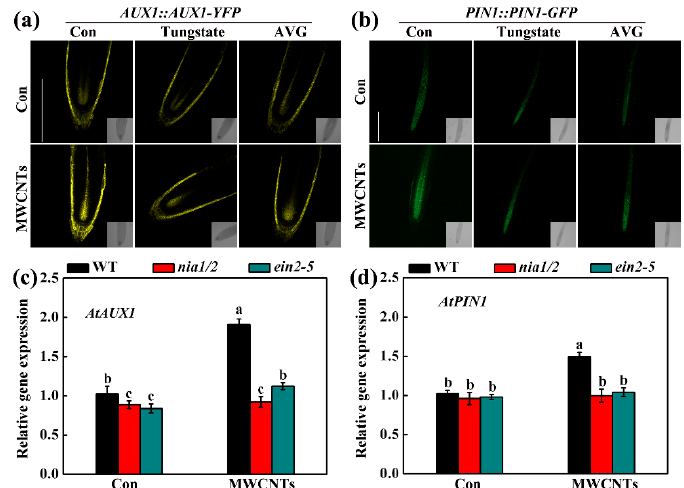
Figure 7. Changes in AUX1 and PIN . Five-day-old Arabidopsis seedlings were treated with 10 mg/L MWCNTs, 50 μ M tungstate, and 2 μ M AVG, alone or their combinations for 24 h. Afterward, the YFP fluorescence images of AUX1::AUX1-YFP ( a ) and the GFP fluorescence images PIN1::PIN1-GFP ( b ) roots were detected by laser scanning confocal microscopy. Scale bar = 0.2 mm. The mRNA expression of AtAUX1 ( c ) and AtPIN1 ( d ) in root tissues were analyzed by qPCR. Bars with different letters are significantly different at p < 0.05, according to Duncan’s multiple range test.